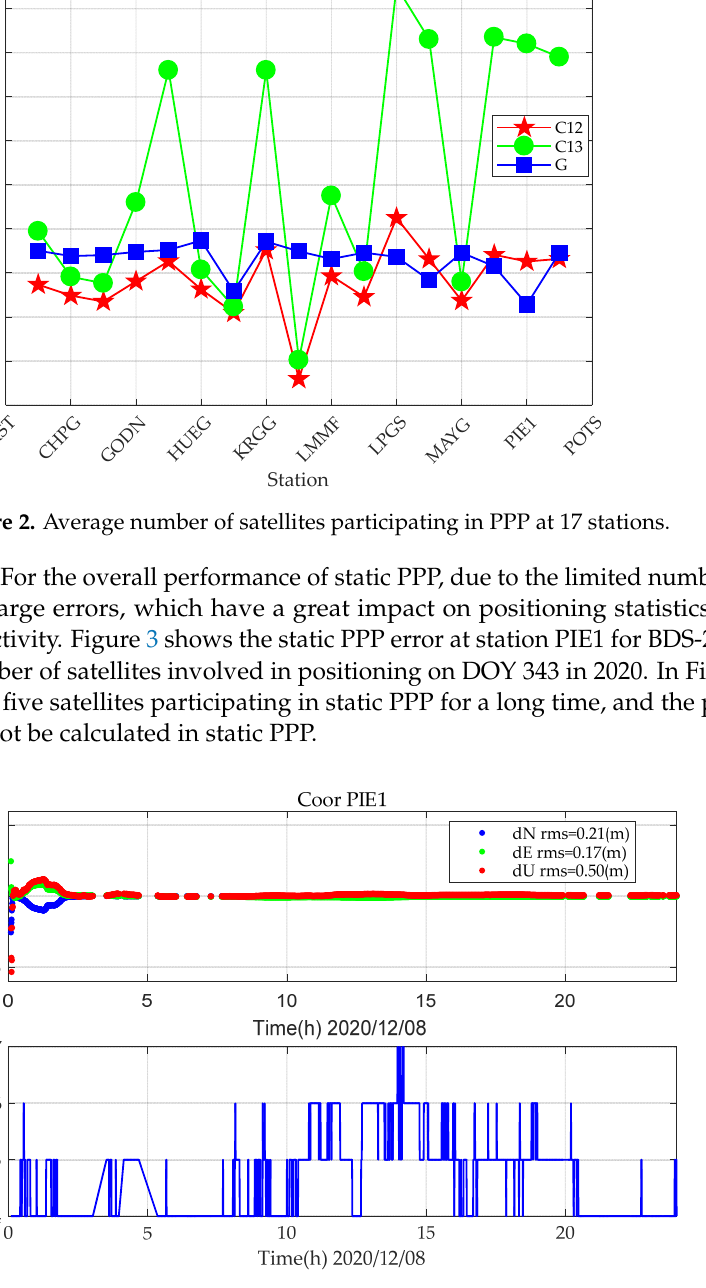
Figure 4. BDS (B1CB2a) kinematic PPP positioning error and number of satellite (DOY342,2020) . Therefore, in the subsequent data analysis, the above cases are excluded. 3.3. Static PPP The precise orbit and clock offset provided by GBM are used to perform static PPP of BDS (B1CB2a). Figure 5 demonstrates a static PPP error series for 20 days at 17 stations utilizing GBM’s precise orbit/clock corrections. All results for the 20 days at 17 stations are plotted in the same figure. The premise is to eliminate the abnormal values in Table 2, where S represents the results for static PPP. It can be seen that all PPP solutions can reach convergence but with significantly different convergence times. In the meantime, the positioning errors in the N and E directions are obviously smaller than those of the U component.